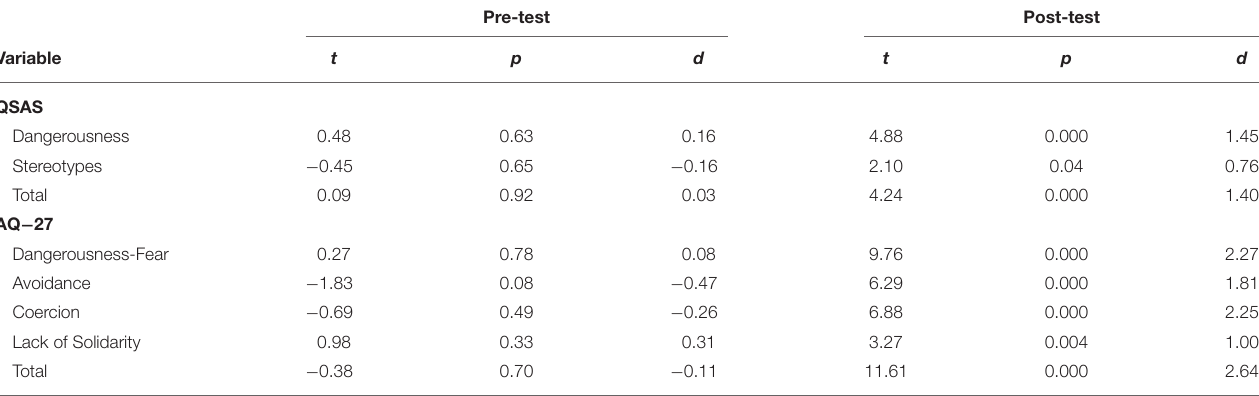
TABLE 1 | Student’s t -test for independent samples of pre-test and post-test differences between the intervention group and control group.